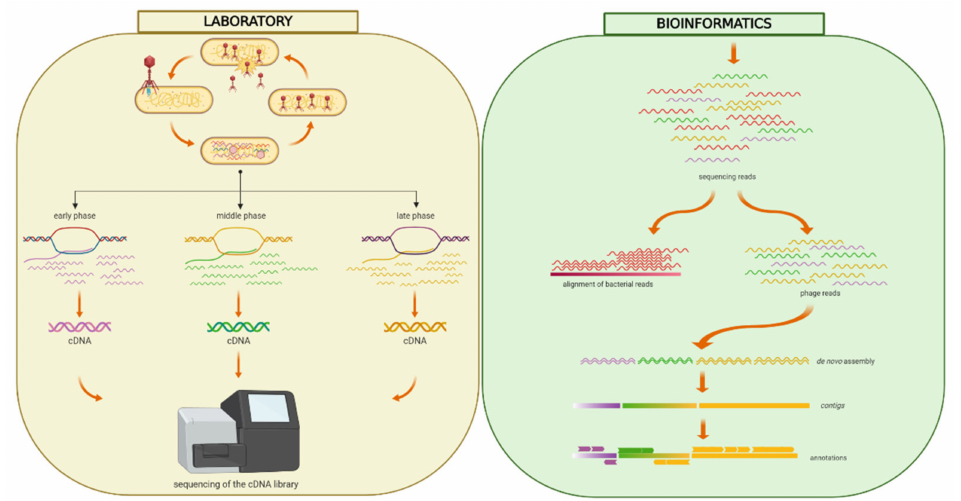
Figure 1. Workflow of the RNA-seq approach. Freshly diluted Y. ruckeri RS41 bacteria were grown until OD 600 = 0.6 and then infected with phage YerA41 at MOI equal to 10 or 50. The culture was washed with LB to remove the unbound phage particles, and thus prevent re-infection of bacterial cells at later stages of the experiment. Samples for RNA isolation were taken at di ff erent time points p.i. (0, 5, 15, 33, 45, 63, 75, 92 min). After the removal of bacterial rRNA, the prepared libraries were sequenced. The obtained sequencing reads were quality filtered and aligned against Y. ruckeri PBH2 chromosome (Acc.no. LN681231.1) and plasmids pYR2 (Acc.no. LN681229.1) and pYR3